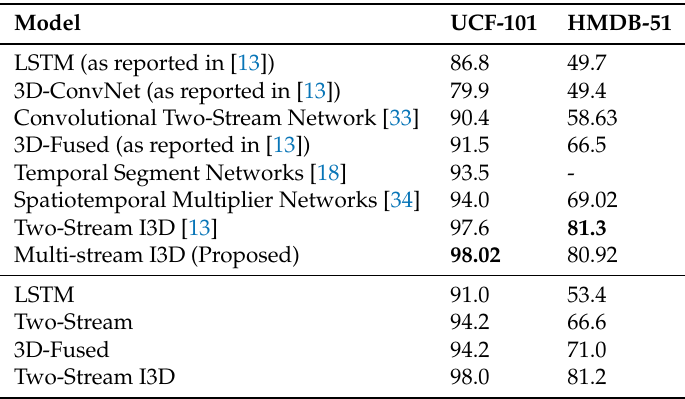
Table 4. Comparison with other